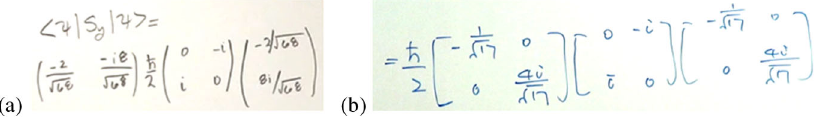
FIG. 1. Students ’ identification of matrix notation where ψ is expressed (a) correctly as a vector and (b) incorrectly as a